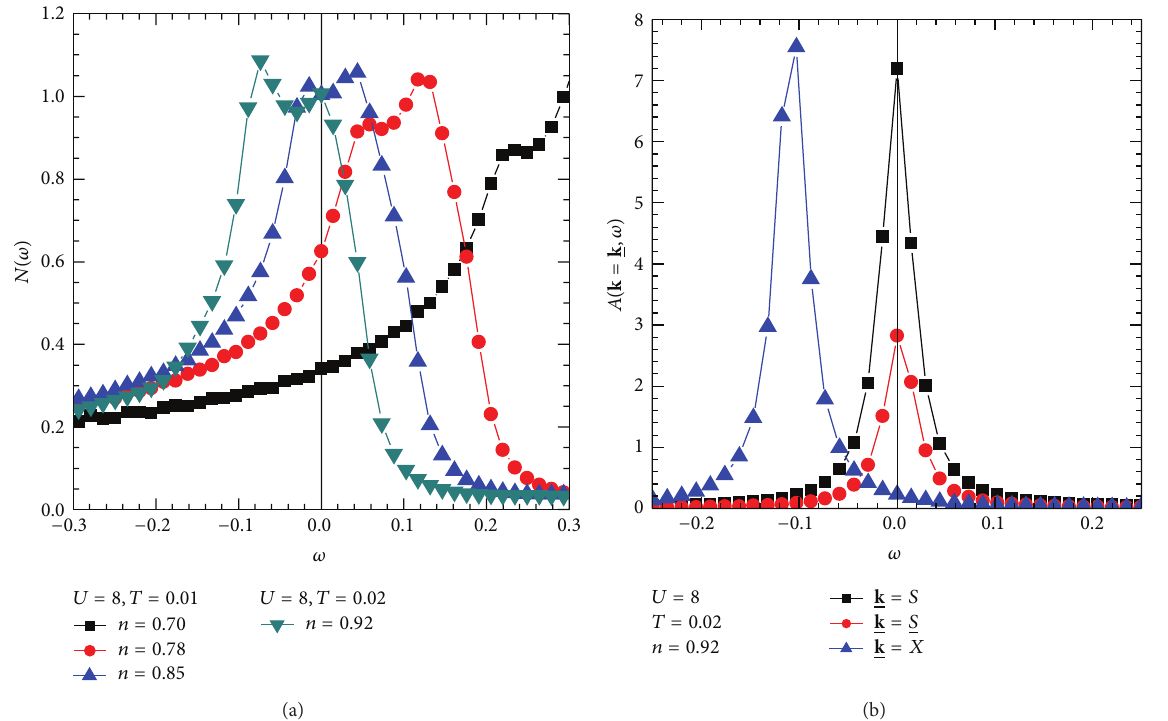
Figure 6: (Color online) (a) Density of states 𝑁(𝜔) as a function of frequency 𝜔 for 𝑈 = 8 , (black squares) 𝑛 = 0.7 and 𝑇 = 0.01 , (red circles) 𝑛 = 0.78 and 𝑇 = 0.01 , (blue up triangles) 𝑛 = 0.85 and 𝑇 = 0.01 , and (green down triangles) 𝑛 = 0.92 and 𝑇 = 0.02 . (b) Spectral function in the proximity of the chemical potential 𝐴( k ,𝜔 ∼ 0) at (black squares) k = 𝑆 = (𝜋/2, 𝜋/2) , (red circles) 𝑆 (in the text), and (blue triangles) 𝑋 = (𝜋,0) for 𝑈 = 8 , 𝑛 = 0.92 , and 𝑇 = 0.02